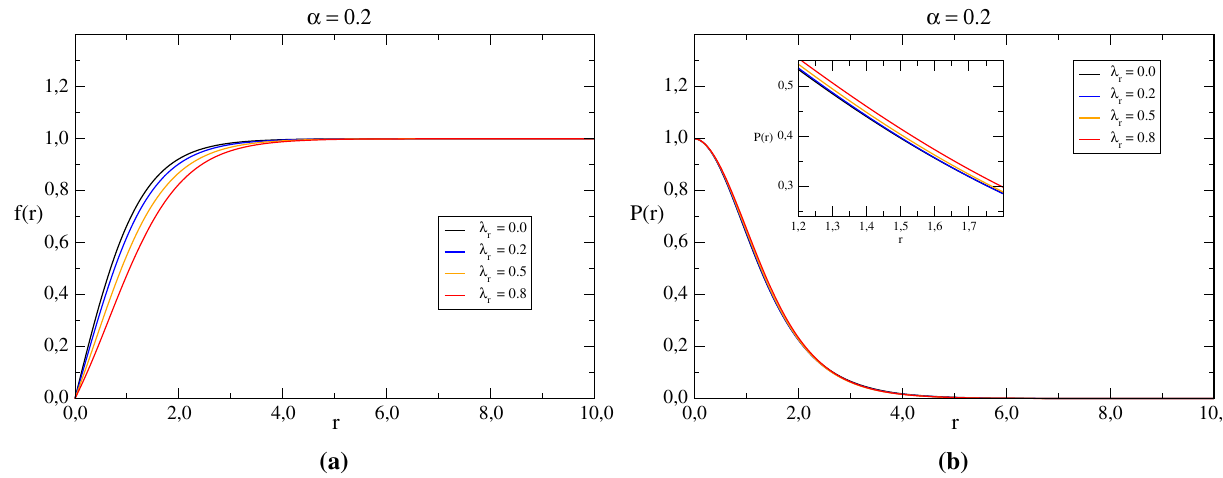
Fig. 1 In the left panel, we present the behavior for the Higgs field as a function of r . In the right panel, the gauge field, P ( r ) , is shown. For the two situations we fix α = 0 . 2 and take successively the values λ r = 0 . 0 , 0 . 2 , 0 . 5 , 0 . 8